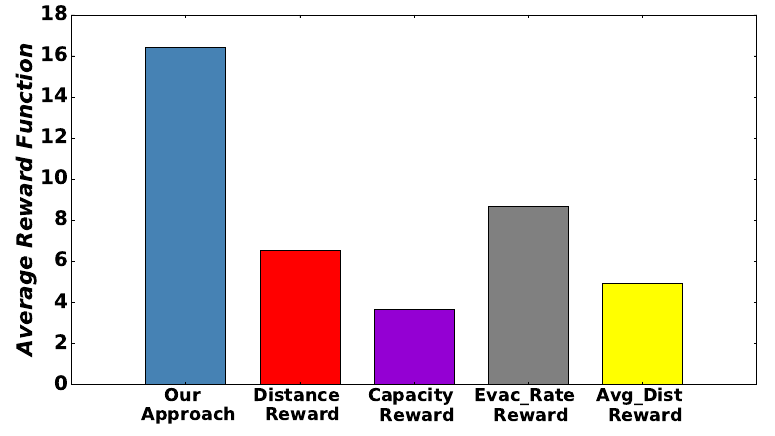
Figure 6. Comparative analysis—Scenario 2: average reward function of all alternative strategies.